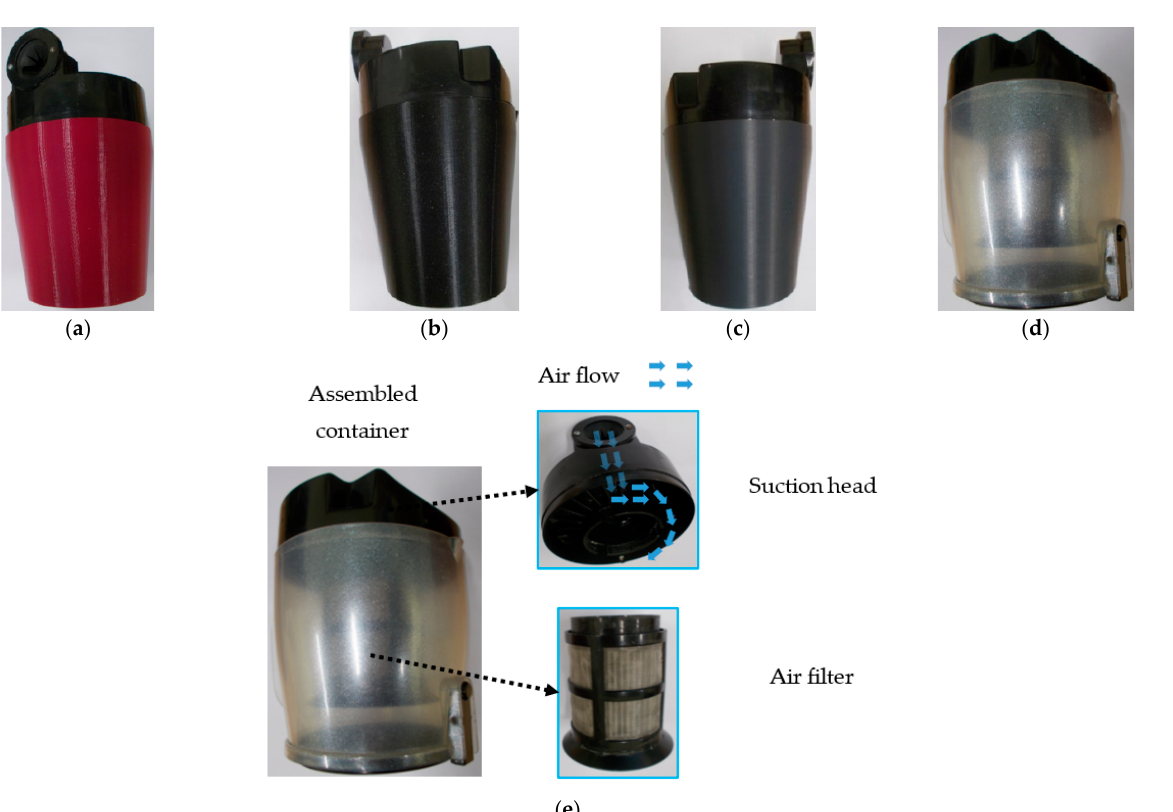
Figure 6. The view of tribocharging containers made of: ( a ) PET-G, ( b ) PLA/ABS, ( c ) ASA, ( d ) PP, ( e ) assembled container, air filter and airflow in suction head.